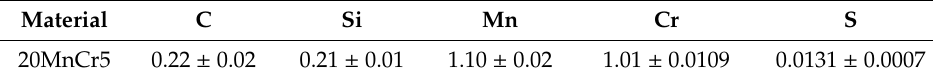
Table 3. Chemical composition of the steel alloy 20MnCr5 in wt.%, the balance is Fe.